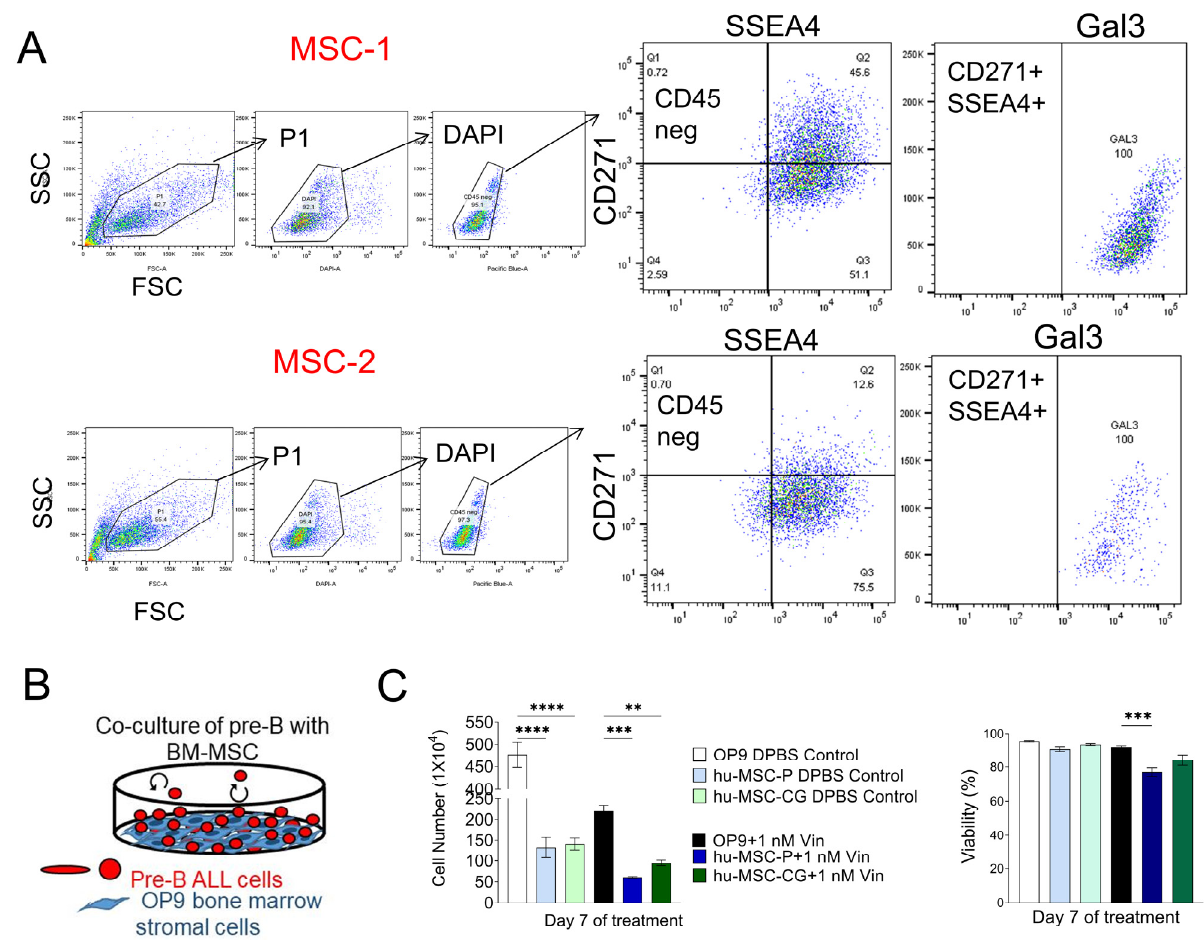
Figure 1. Bone marrow stromal cells produce galectin-3. ( A ) MSC from two different normal BMT donor screens MSC-1 and MSC-2 were grown out as adherent cells. FACS analysis on the indicated populations using the gating strategy shown in the figure. ( B ) Schematic co-culture system. Stromal cells have been mitotically inactivated. They support the leukemia cells but no longer can divide. ( C ) Comparison of human primary bone marrow MSC with mouse bone marrow MSC OP9 cells for ability to protect human BCP-ALL US7 cells against chemotherapy. Right panel: viability (viable cell number/total cell number × 100) determined using Trypan blue. Left panel: total cell number. Stromal cells were mitotically inactivated by treatment with 10 µ g/mL mitomycin C. Analysis on day seven of 1 nM vincristine treatment (comparison with OP9 cells, triplicate samples harvested in a single experiment. One-way ANOVA, Tukey’s multiple comparisons). hMSC-1 and hMSC-CG, primary and immortalized human MSC. ** p < 0.01, *** p < 0.001, **** p < 0.0001.